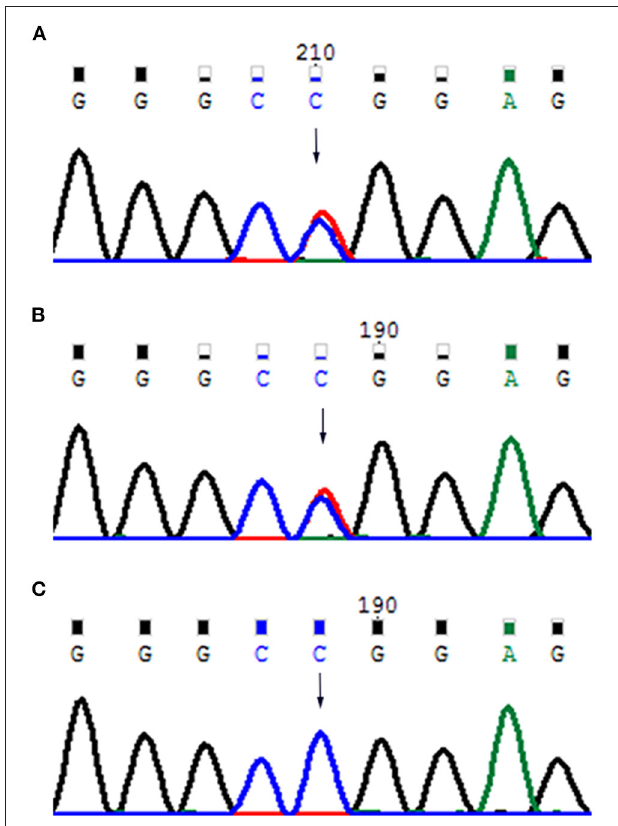
FIGURE 4 | (A) Father’s mutant RUNX2 gene; (B) baby’s mutant RUNX2 gene; (C) mother’s wild-type RUNX2